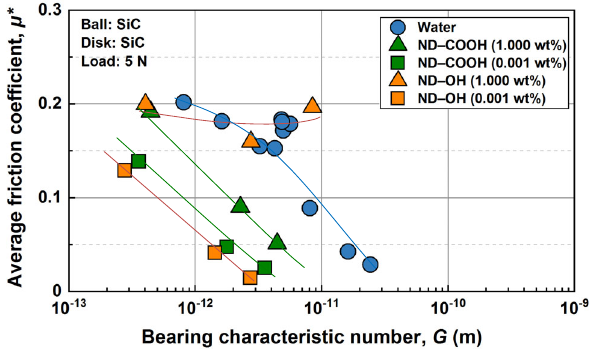
Fig. 10 Stribeck curves in NDP–COOH, NDP–OH, and water. Two concentrations (1 wt% and 0.001 wt%) are analyzed for NDP-added